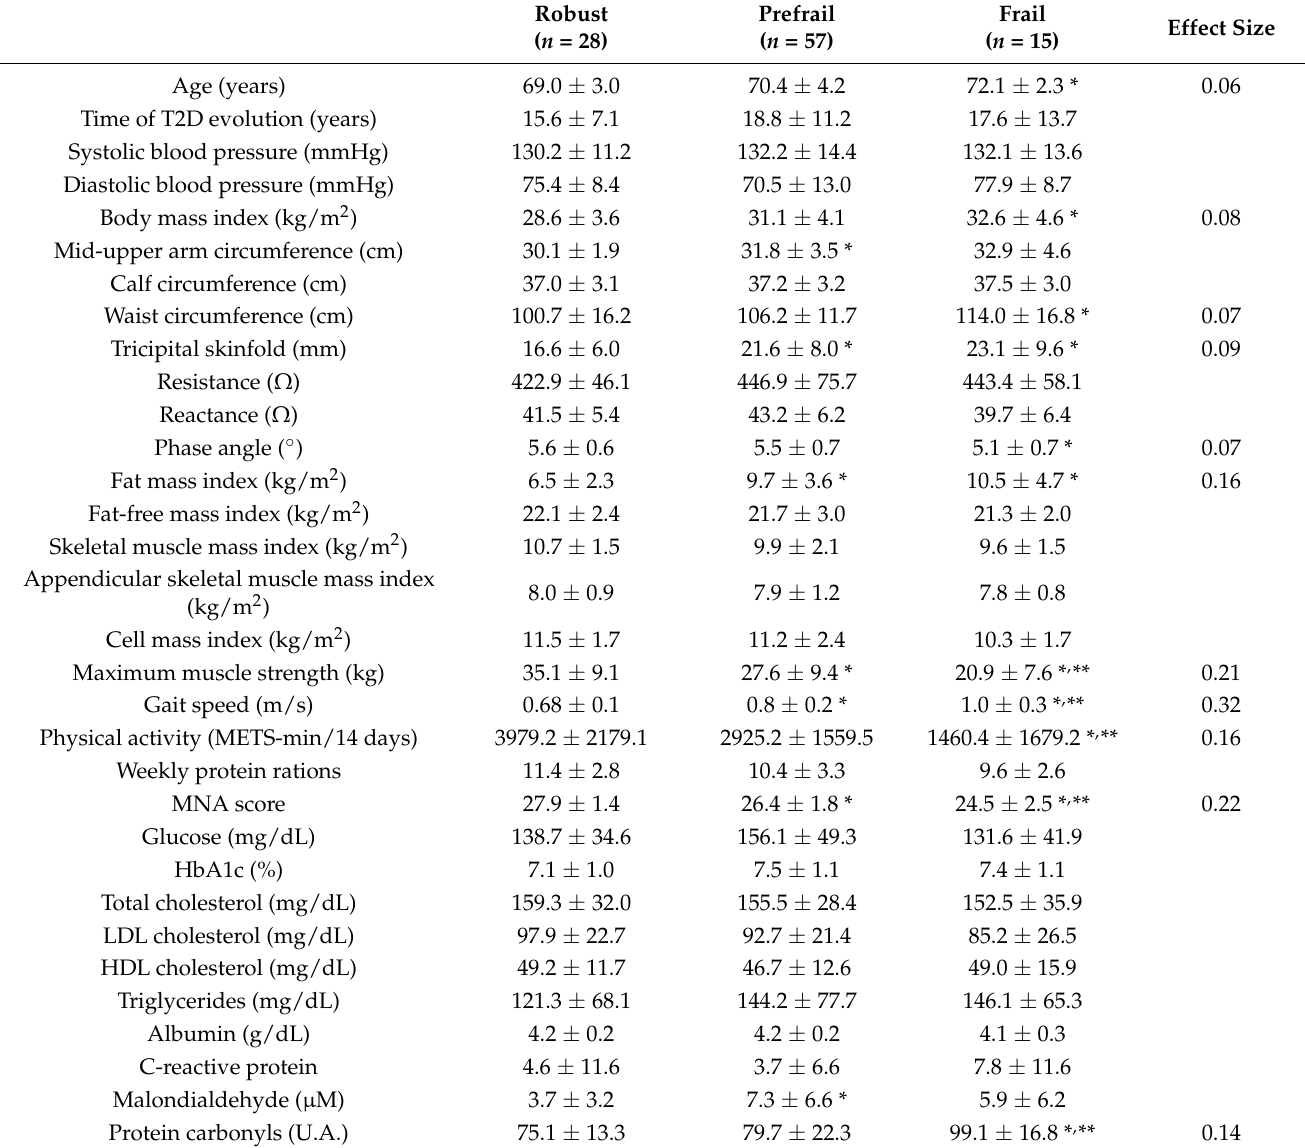
Table 3. Characteristics of the patients with type 2 diabetes according to frailty